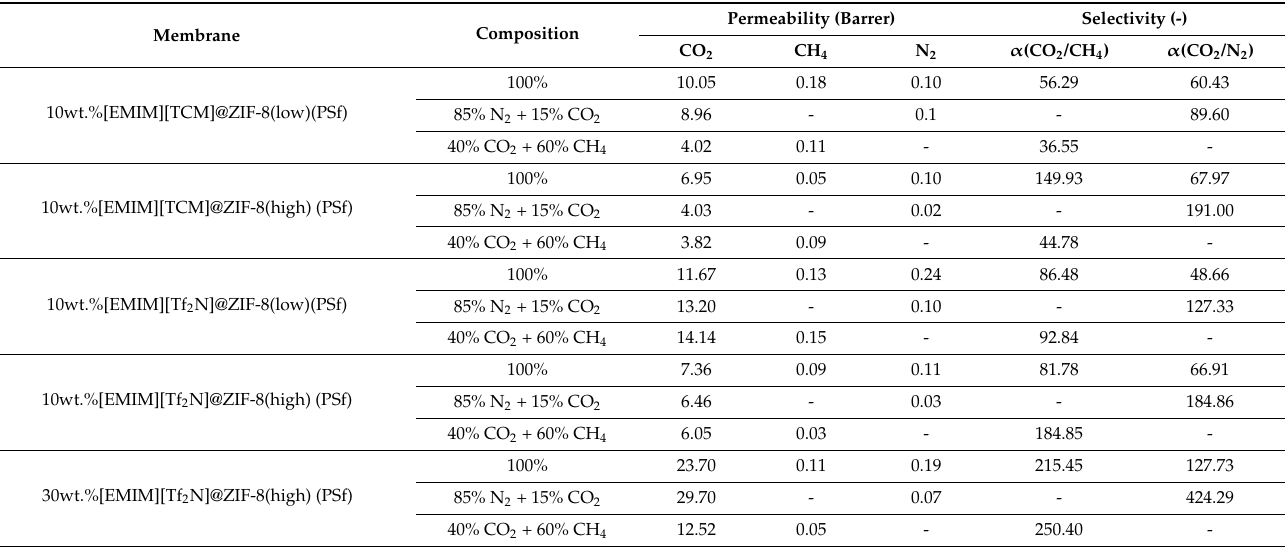
Table 3. Gas permeability and selectivity values of IL@ZIF-8 MMMs pure gas at 303.15 K for pure gas and two binary mixtures: 85% N 2 + 15% CO 2 and 40% CO 2 + 60% CH 4 . Permeability (Barrer) Selectivity Membrane Composition